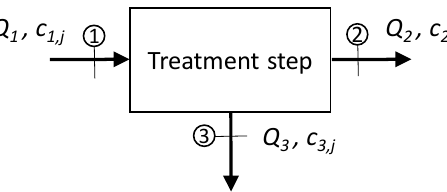
Figure 4. Representation of a generic wastewater treatment step, for instance an activated sludge system with the two effluents: a liquid phase (the clarified effluent, stream number 2) and the solid phase that is the excess sludge (stream number 3). In the case of a treatment step with only one effluent stream, stream number 3 does not appear.